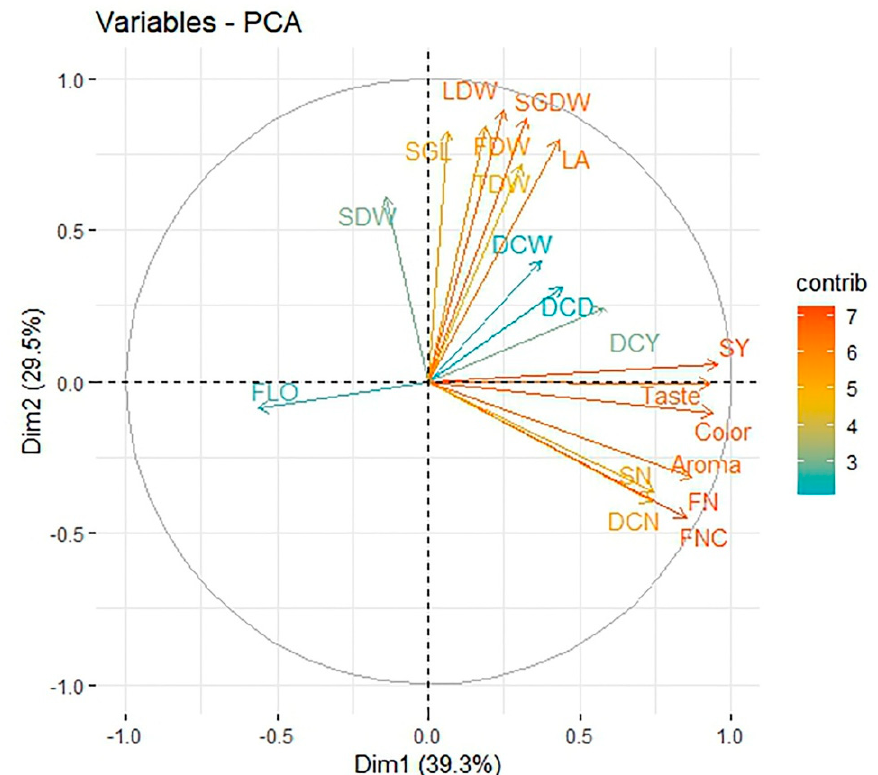
Figure 2. Correlation biplot of the two first principal component variables in the two-dimensional space. FLO = Day to Flower; SGL = Stigma Length; SGDW = Stigma Dry Weight; SDW = Stamen Dry Weight; TDW = Tepal Dry Weight; FDW = Flower Dry Weight; FNC = Flower Number per Corm; FN = Flower Number; SY = Stigma Yield; DCN = Daughter Corm Number; DCW = Daughter Corm Weight; DCD = Daughter Corm Diameter; DCY = Daughter Corm Yield; LDW = Leaf Dry Weight; LA = Leaf Area; SN = Shoot Number.